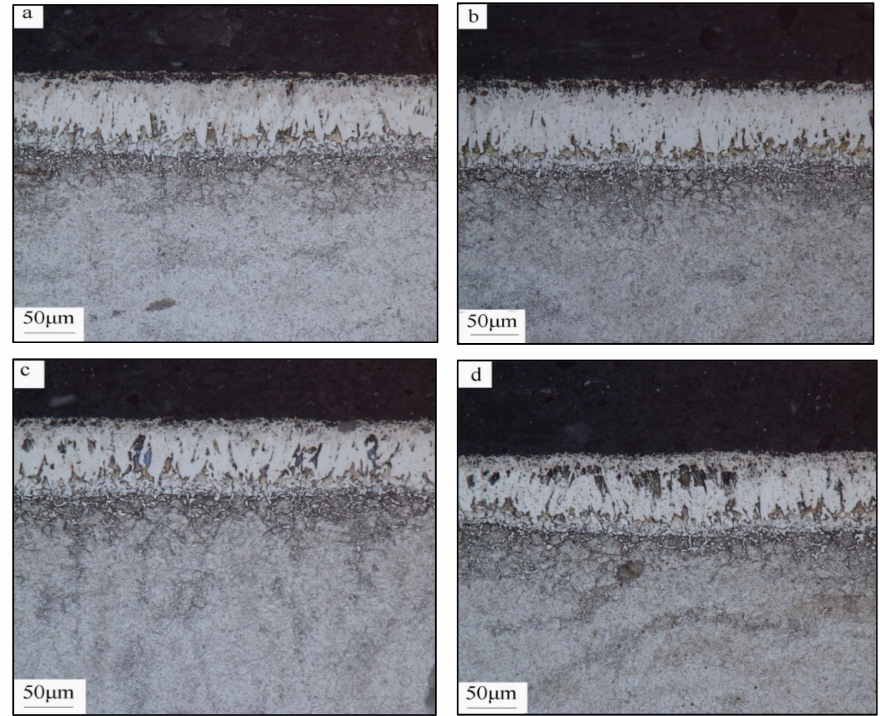
Figure 4. Microstructure of boronizing layer with Cr 2 O 3 content of 1%, 2%, 3%, and 4%, respectively.